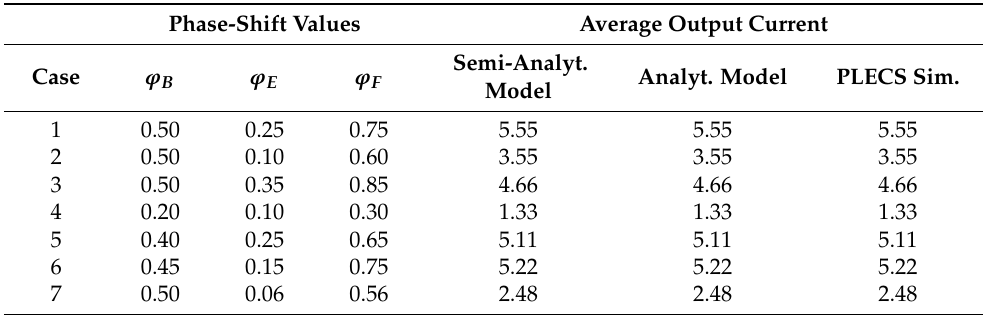
Table 2. Simulation of the ideal converter vs. analytical models: comparison of average output current with different combinations of phase-shift values.